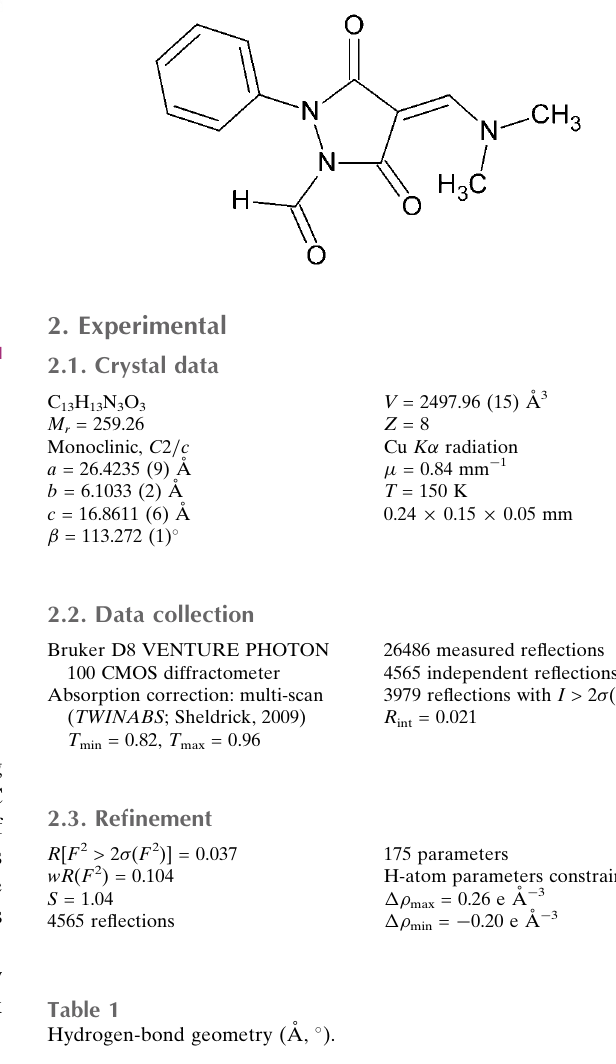
Hydrogen-bond geometry (A˚ , (cid:2)